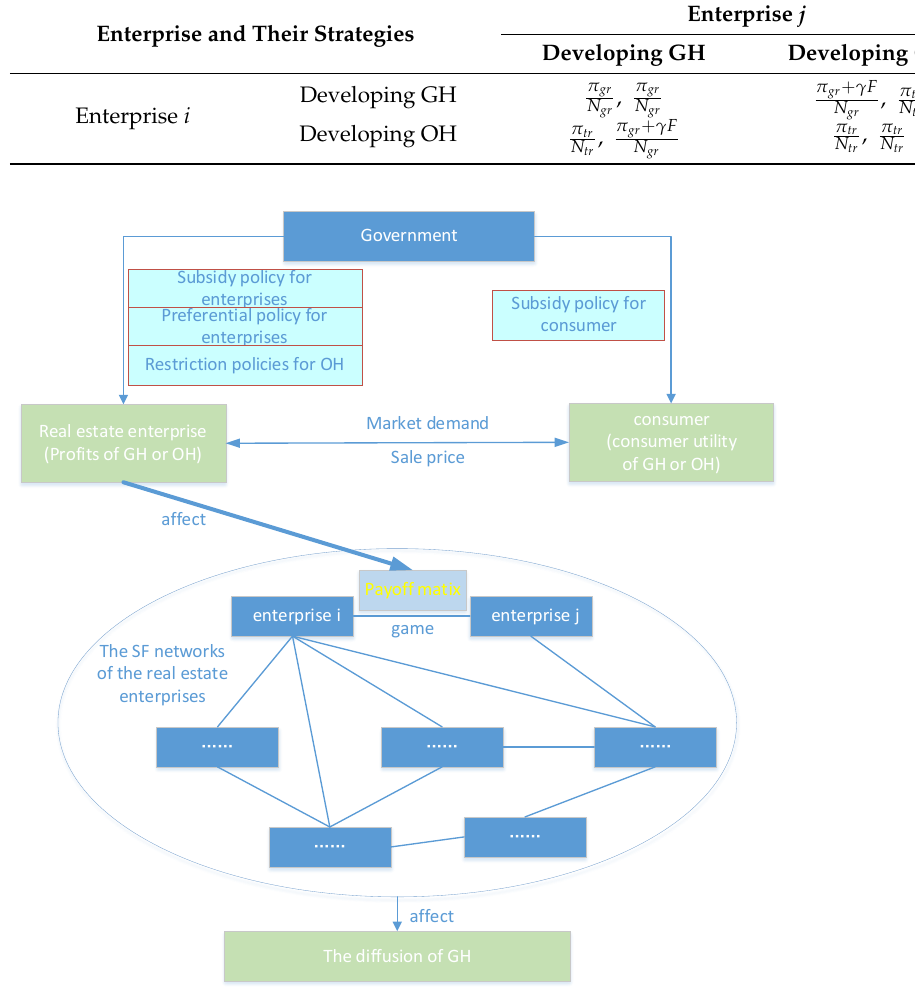
Figure 2. Diagram of the networked evolutionary game for GH diffusion.